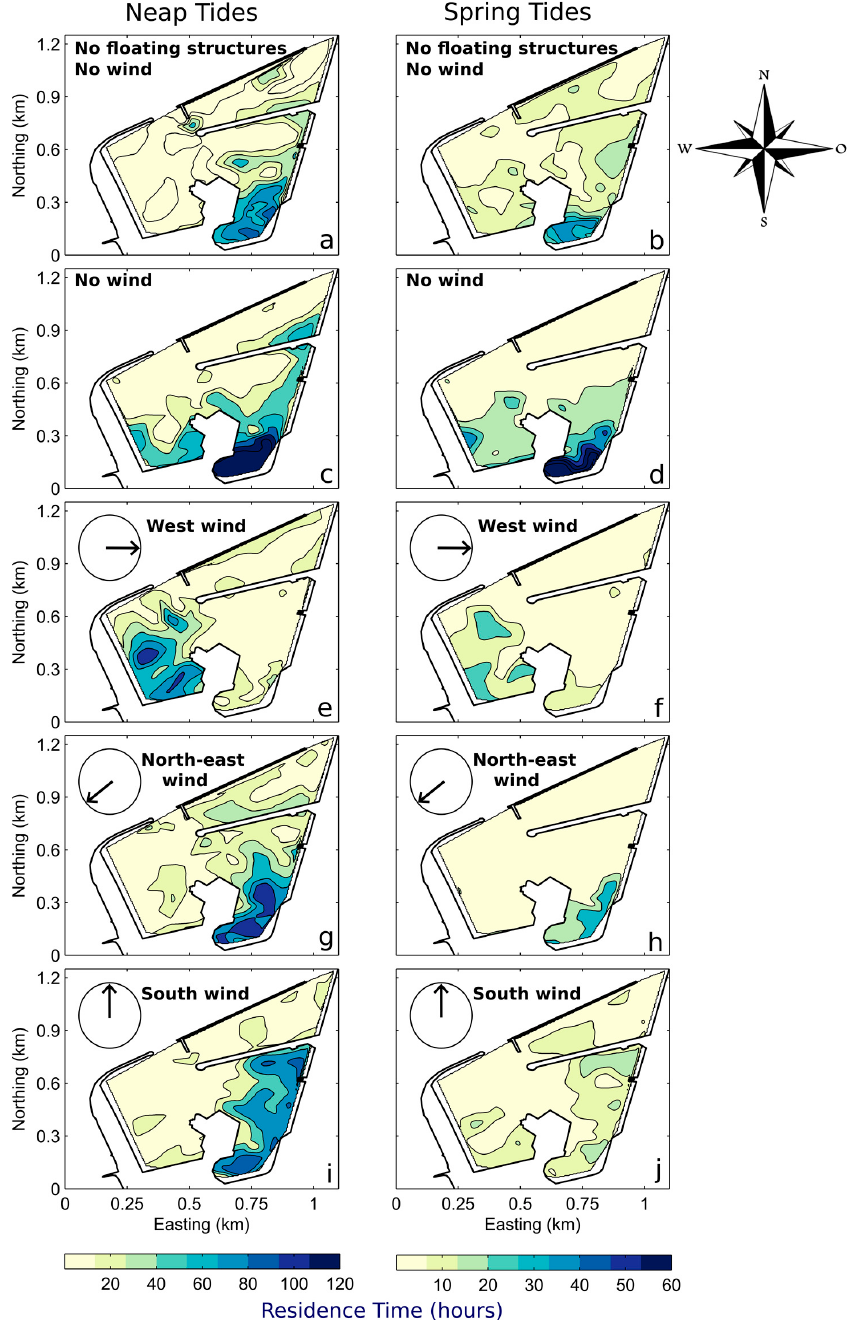
Figure 5. Spatial distribution of vertically-averaged Residence Time (expressed in hours) within the La Rochelle marina computed for each scenario (letters) defined in Table 1. Rows characterise the wind and FS configurations and columns correspond to the tidal regime. and FS configurations and columns correspond to the tidal